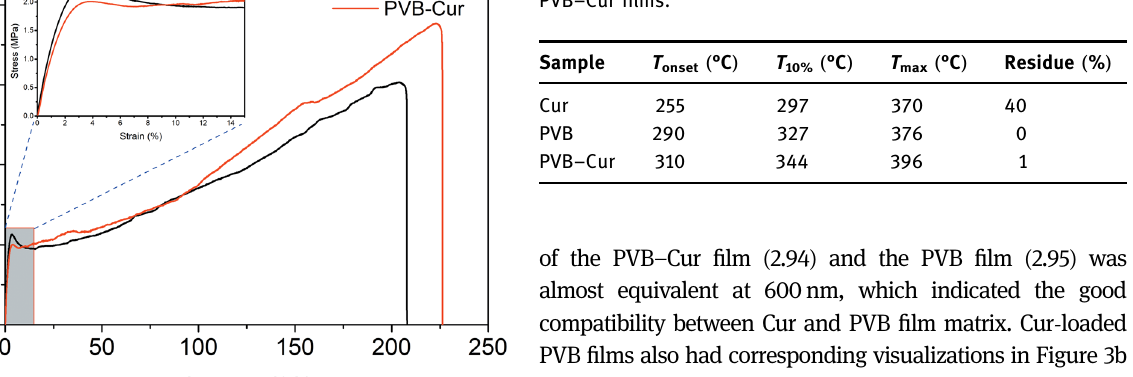
Table 1: Thermal stability parameters for the PVB and